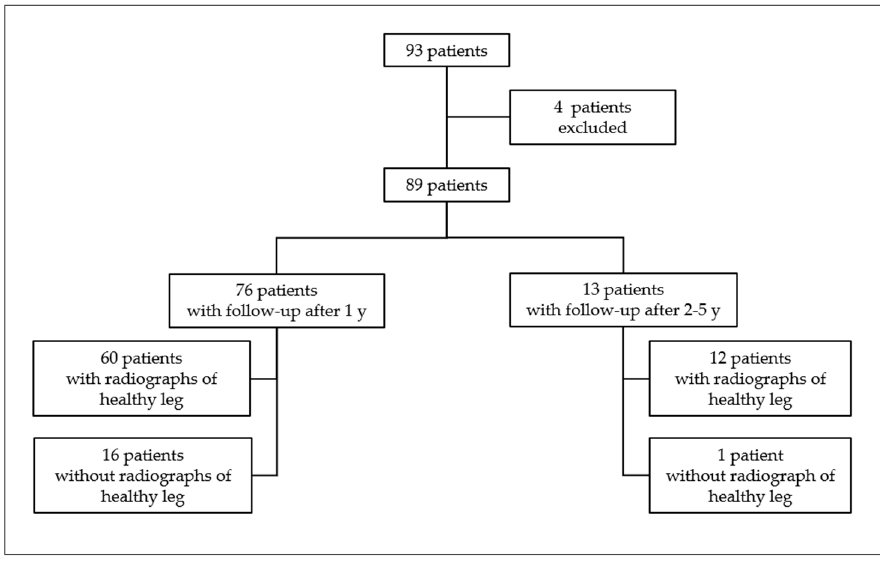
Figure 2. Distribution of our study population.